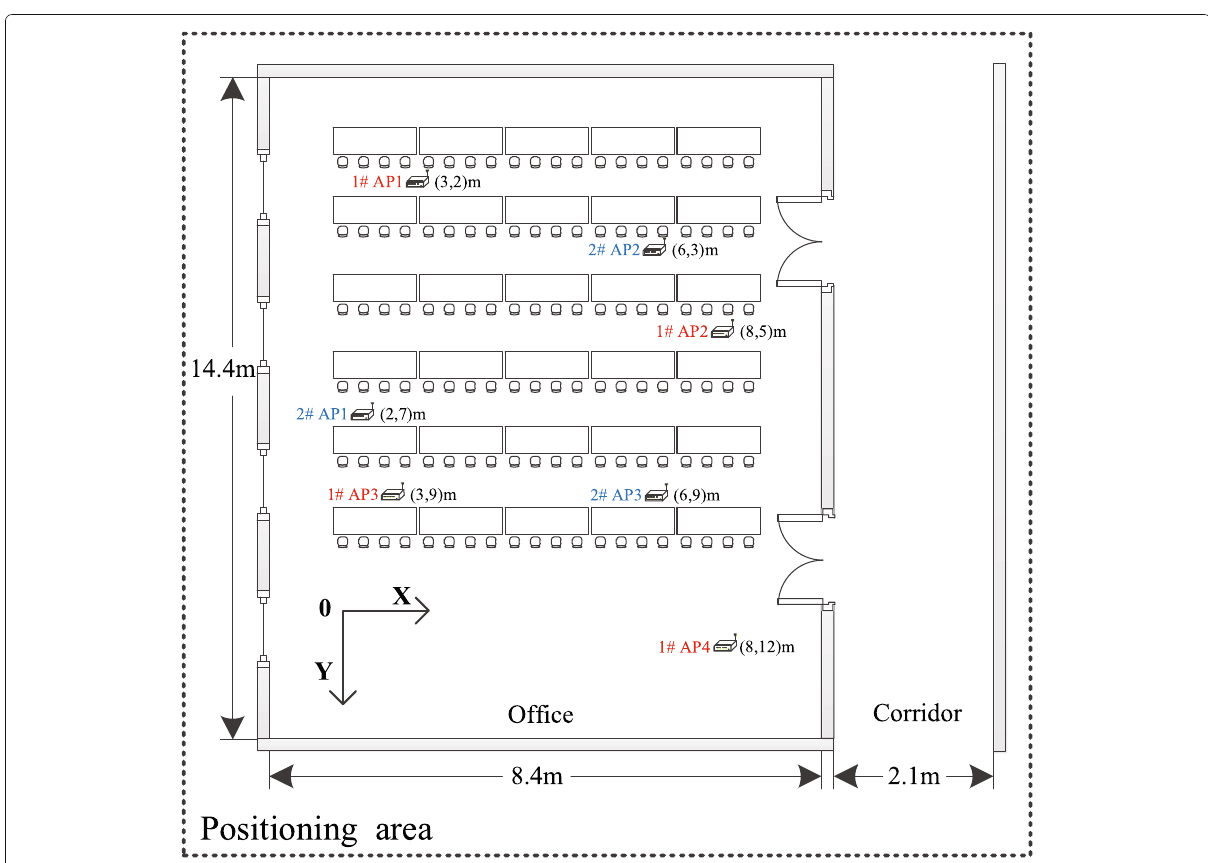
Fig. 15 Layout of the positioning area. The positioning area consists of two parts: office and corridor, which area are 14.4 m × 8.4 m and 14.4 m × 2.1 m